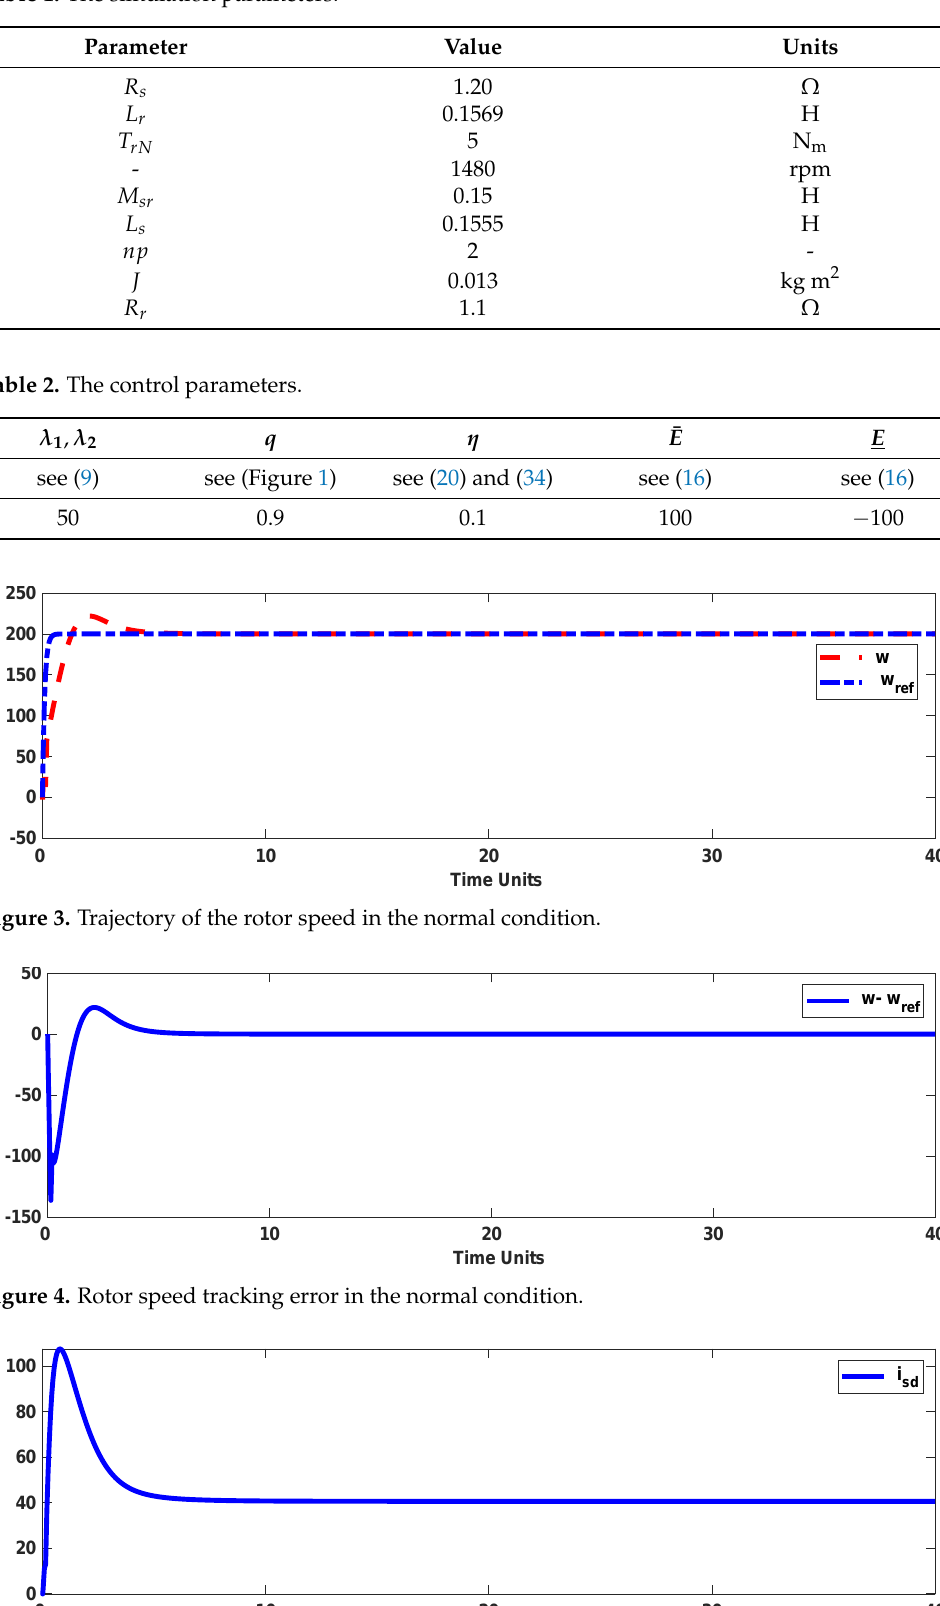
Table 1. The simulation parameters.